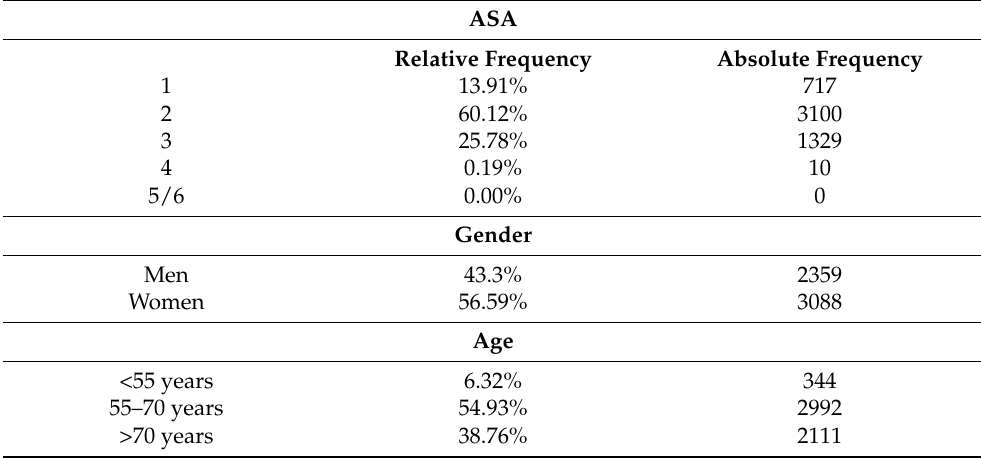
Table 1. The relative and absolute frequencies of ASA score ( n = 5156), gender ( n = 5447) and age ( n = 5447).